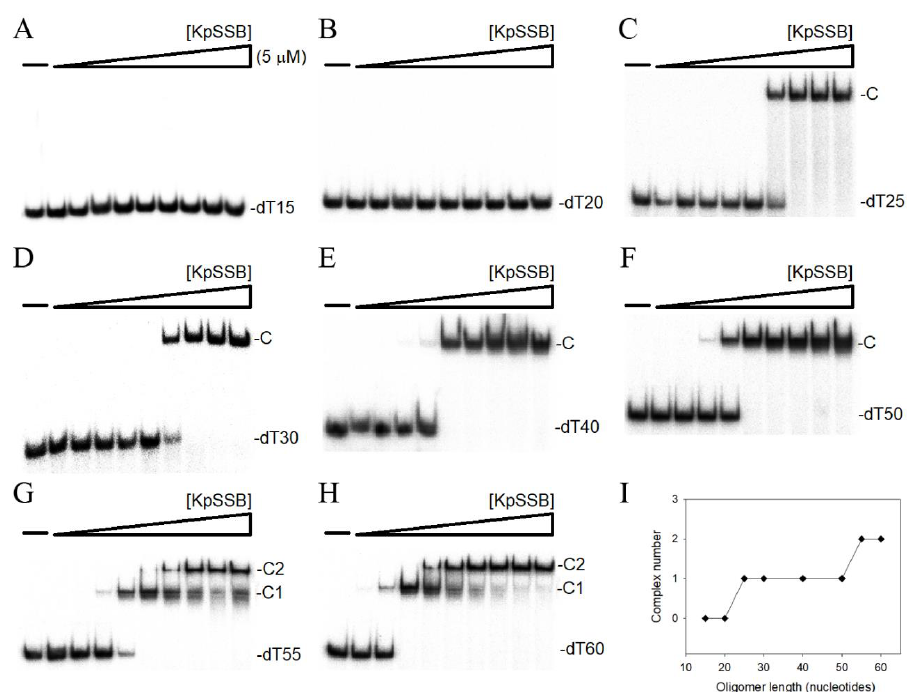
Figure 7. EMSA of KpSSB. Protein (0–5 µ M) was incubated at 25 ◦ C for 30 min with 1.7 nM of ( A ) dT15, ( B ) dT20, ( C ) dT25, ( D ) dT30, ( E ) dT40, ( F ) dT50, ( G ) dT55, or ( H ) dT60 in a total volume of 10 µ L in 20 mM Tris–HCl (pH 8.0) and 100 mM NaCl. ( I ) Summary of the complex number of KpSSB. Complex number of KpSSB as a function of the length of the ssDNA determined using EMSA. Table 3. ssDNA binding properties of KpSSB, KpPriB, and PriB-SSBc as analyzed by EMSA. DNA